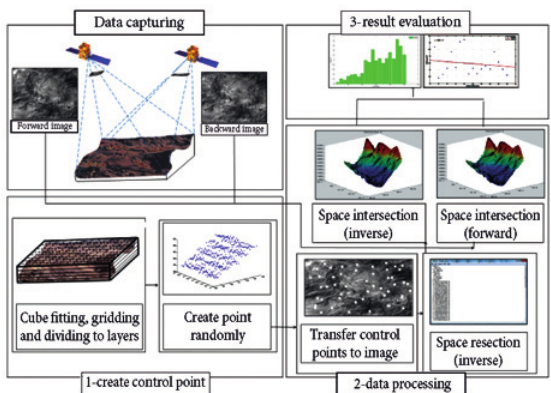
Fig. 2. The flowchart of proposed method for conversion of forward RPCs to the inverse